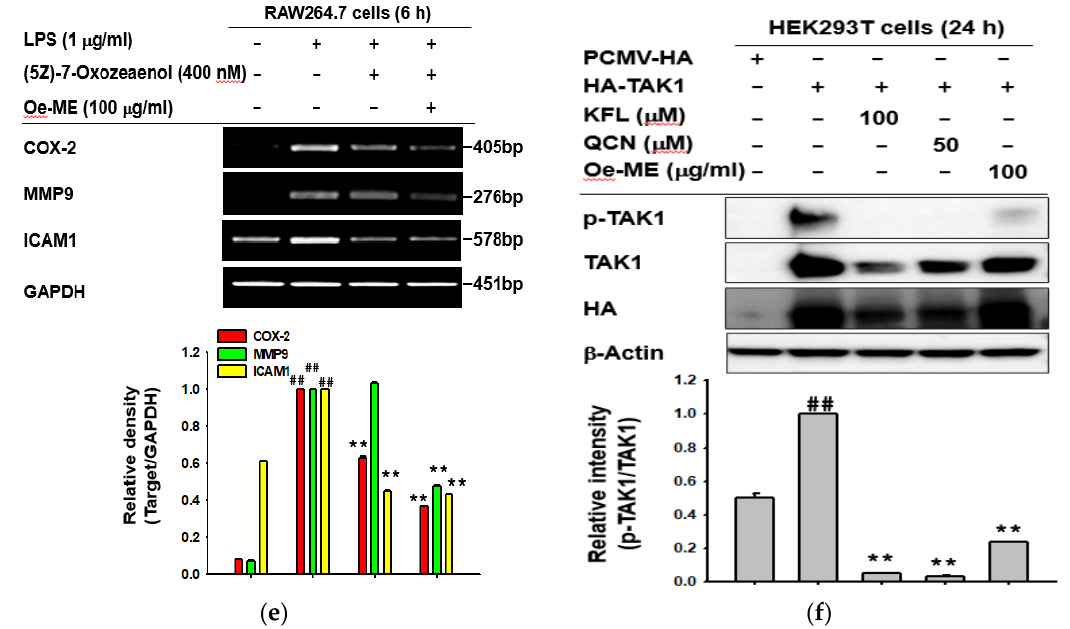
Figure 4. Confirmation of TAK1 as the target of Oe-ME. ( a , f ) HEK293T cells were transfected with either PCMV-HA or HA-TAK1 plasmids for 24 h and further treated with Oe-ME or its known ingredients, quercetin (QCN) and kaempferol (KFL). The target proteins, including the total TAK1, were detected by western blotting analysis. ( b ) After incubation with the HA-TAK1 plasmid, HEK293T cells were collected. Lysis from vehicle- and Oe-ME-treated cells were subjected to CETSA by western blotting analysis. ( c ) The viability of (5Z)-7-oxozeaenol-treated RAW264.7 cells for 24 h was determined by an MTT assay. ( d ) Upon LPS induction, the inhibitory effect of Oe-ME on NO production was explored by Griess assay. ( e ) The expression levels of COX-2, MMP-9, and ICAM1 in (5Z)-7-oxozeaenol-treated RAW264.7 cells during LPS exposure were measured by RT-PCR. Band intensity was measured and quantified using ImageJ. ## p < 0.01 compared with the normal group, and * p < 0.05 and ** p < 0.01 compared with LPS alone or the TAK1 overexpression group treated with the corresponding concentration of the vehicle (DMSO).